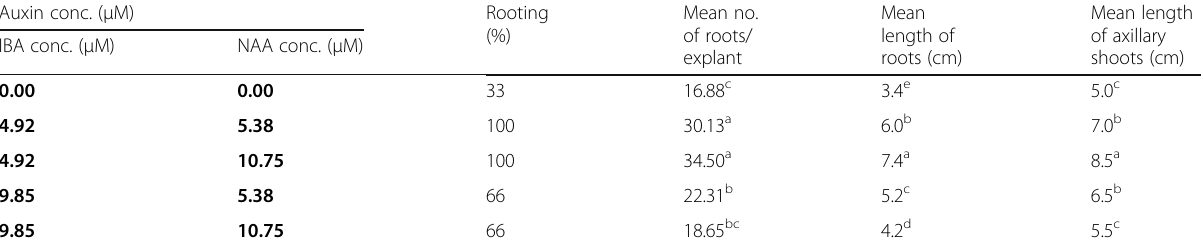
Table 3 Effect of quarter-strength Murashige and Skoog (¼ MS) medium supplemented with indole-3-butyric acid (IBA) and α - naphthaleneacetic acid (NAA) at different combinations on the rooting of Silene schimperiana multiple shoot clusters Auxin conc. ( μ M) Rooting